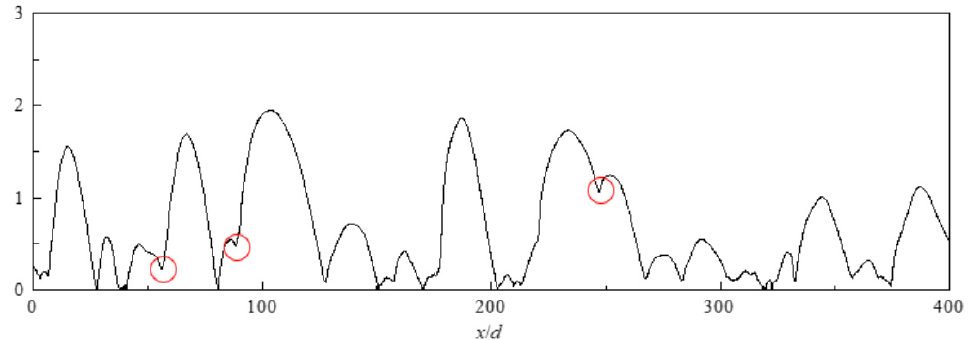
Figure 8. Probability density distributions of dimensionless saltation length and saltation height.